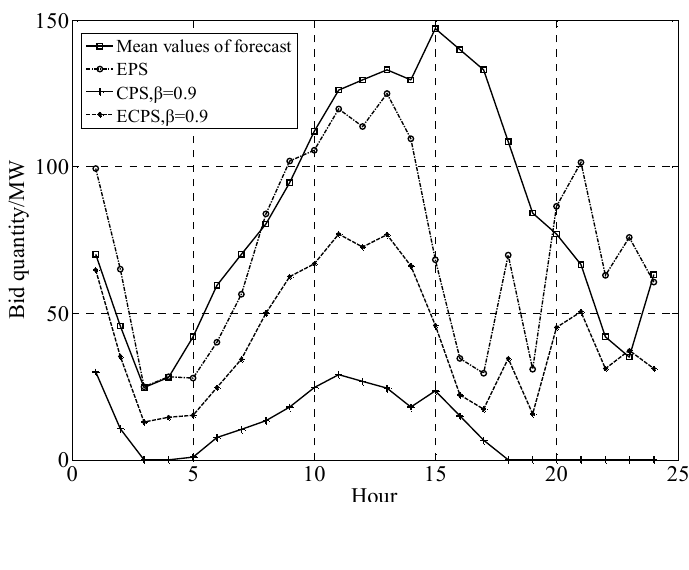
Figure 11. Bid quantity with 24